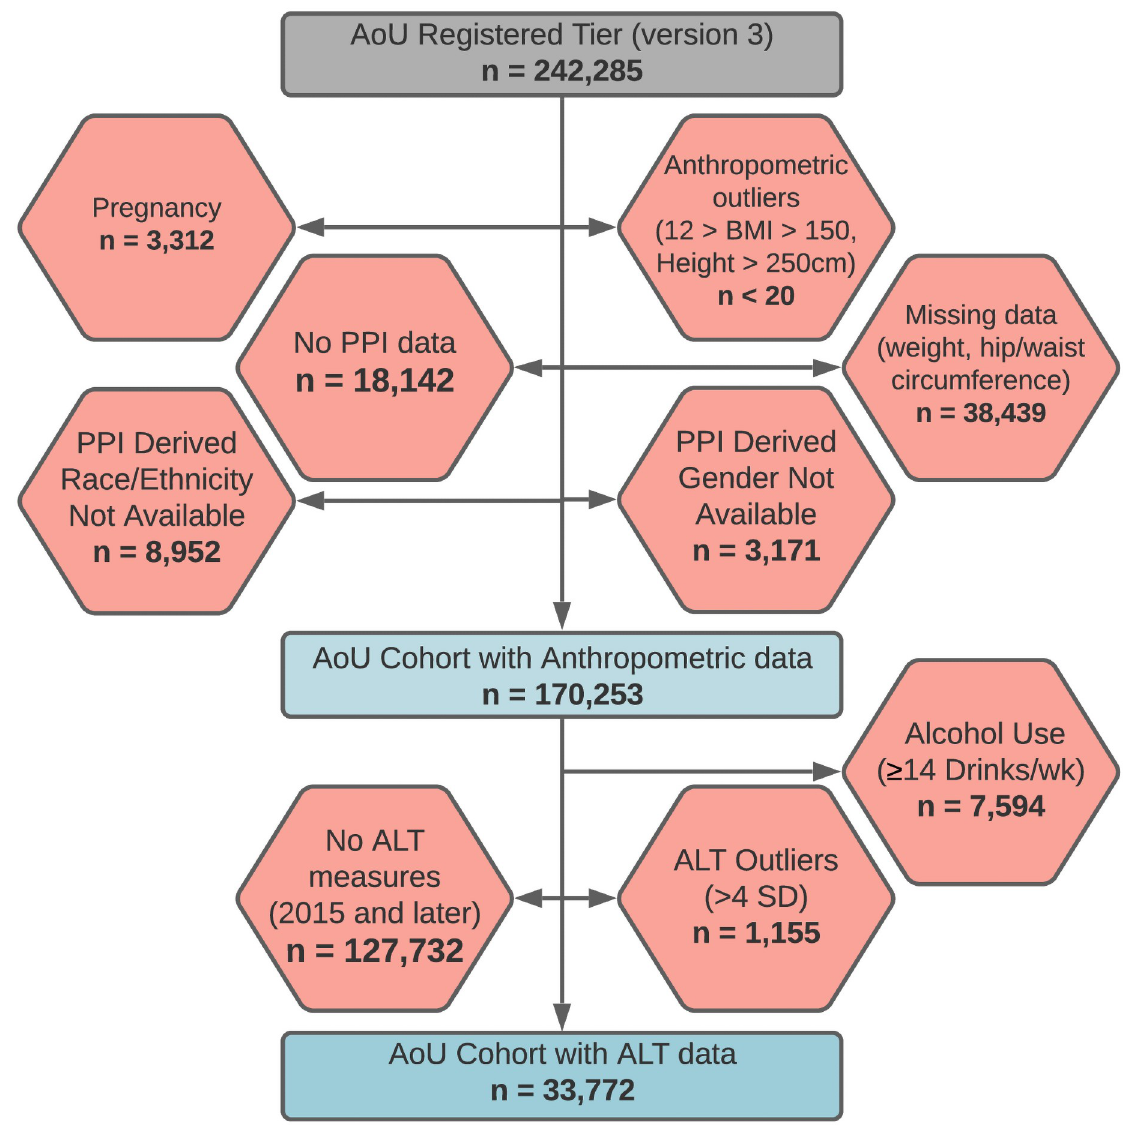
Fig 1. Creation of AoU cohort with anthropometric data and AoU cohort with ALT data from all participants in AoU registered tier data. Participants were removed from AoU Registered Tier data for the current study based on exclusion criteria, outlying observations, availability of data, and responses to PPI-based questions regarding race/ethnicity and gender. All participants in the AoU cohort with ALT data are included in the AoU cohort with anthropometric data. ALT indicates Alanine Aminotransferase; AoU, All of Us Research Program; BMI, body mass index; cm, centimeters; PPI, participant-provided information; SD, standard deviation; wk,